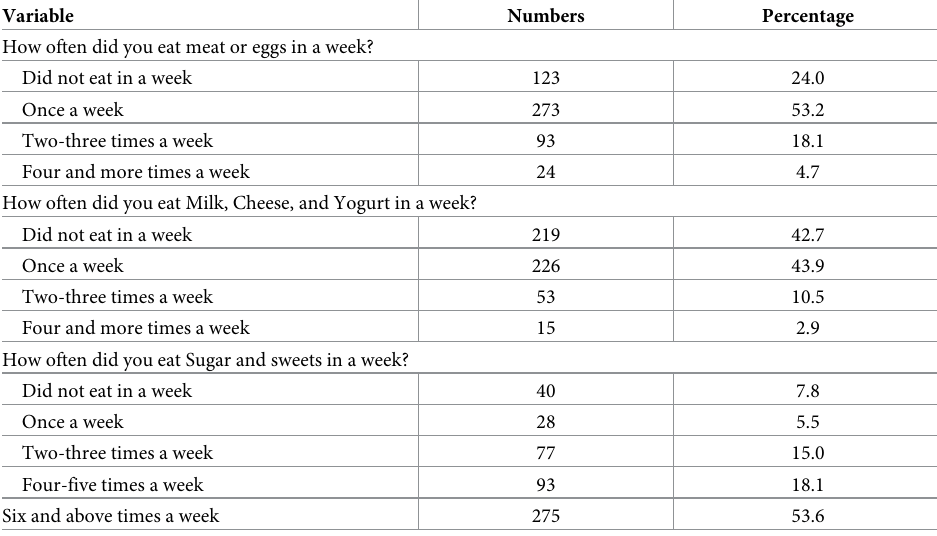
Table 3. Eating habits of respondents in Welkite town of Southern Ethiopia, 2020, [n = 513].